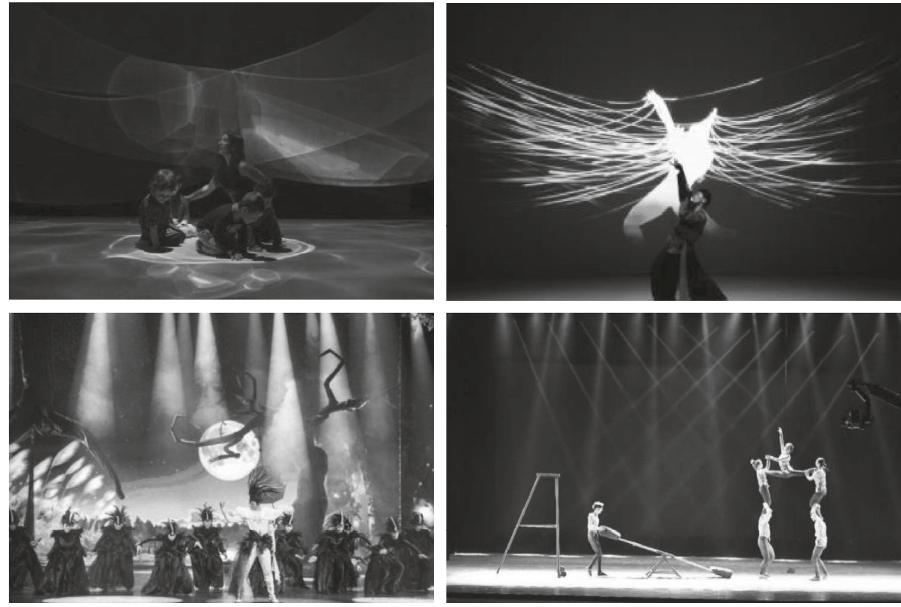
Figure 1: Multimedia interaction combined with